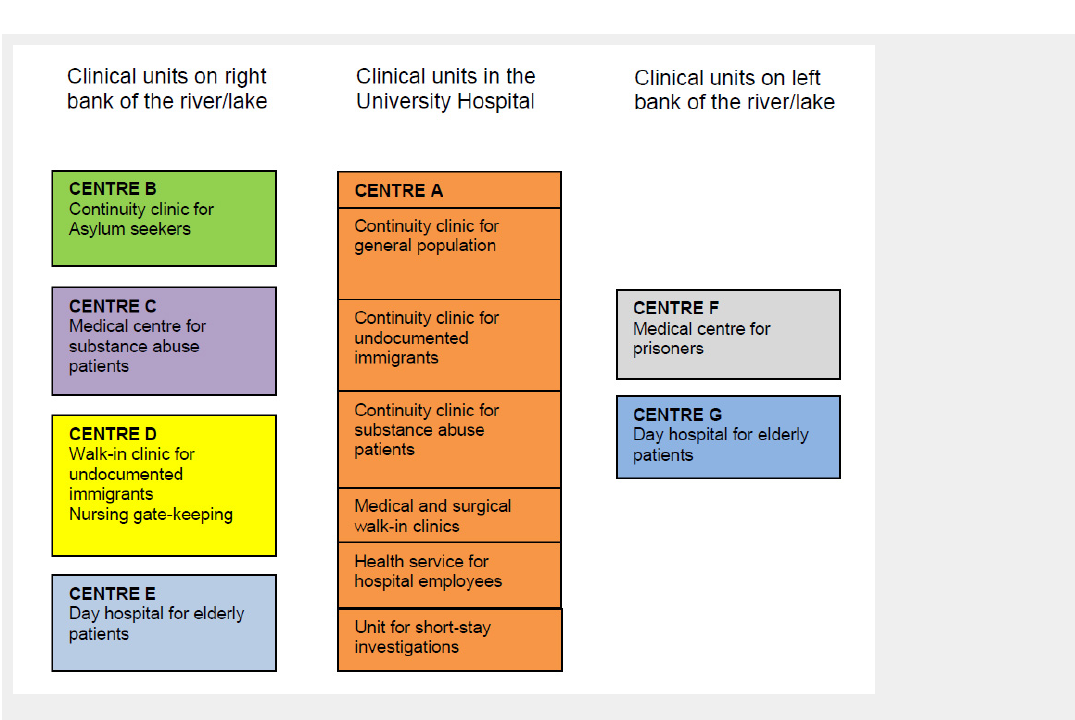
Figure 1 Medical sites and units belonging to the Division of Primary Care Medicine.